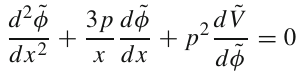
| ˜ φ | < 1, the second derivative of the potential is given by